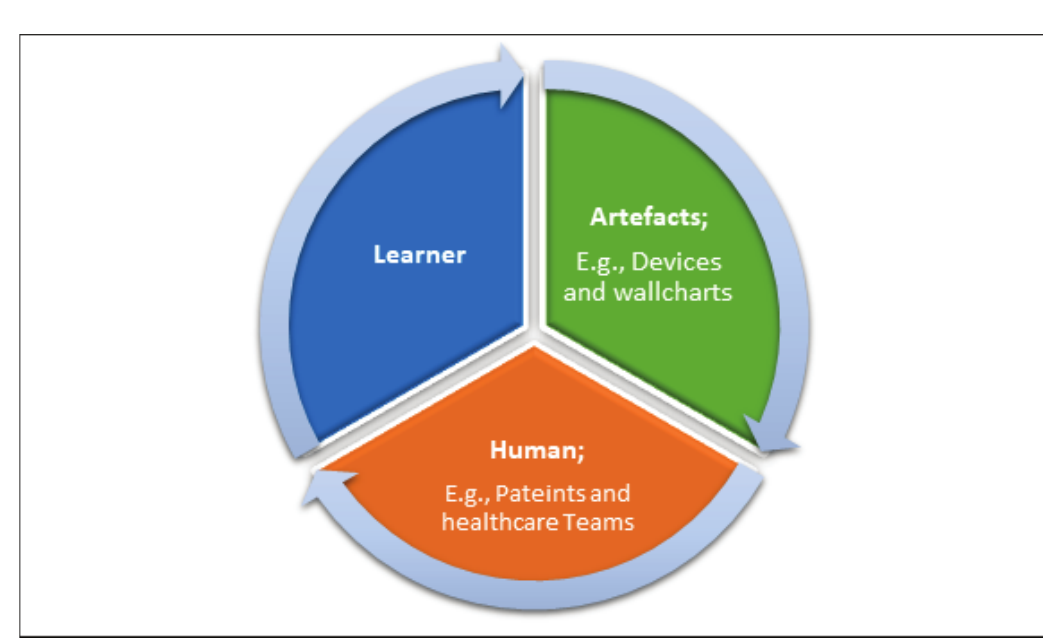
Figure 2: The sociocultural learning